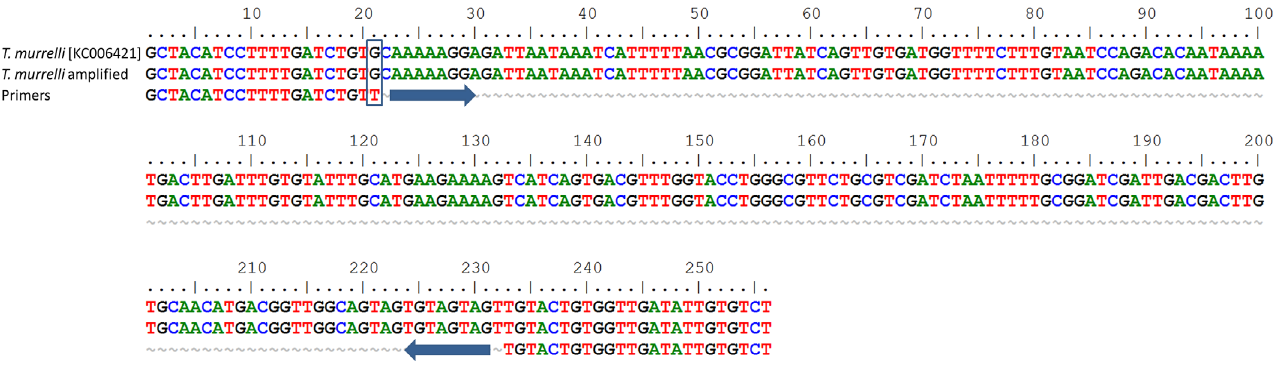
Figure 3. Alignment of the 256 bp fragment of ITS1 II of Trichinella murrelli obtained by uniplex PCR.BLAST analysis revealed 99.6% identity with different clones of T. murrelli , including clone 5 (Accession number